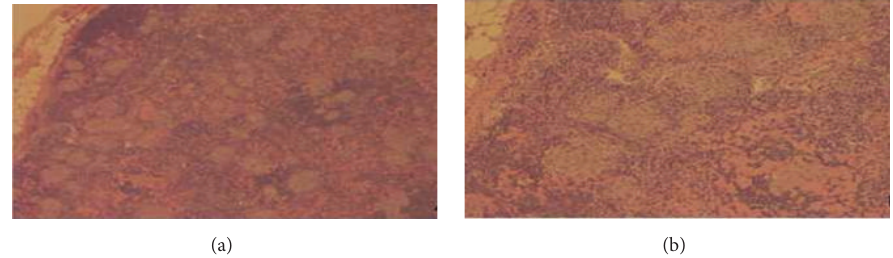
Figure 3: Nonnecrotizing granulomata. Low- (a) and high-magnification (b) photomicrograph of a section from an inguinal lymph node. It shows that the lymph node is replaced by numerous small compact nonnecrotizing granulomata.